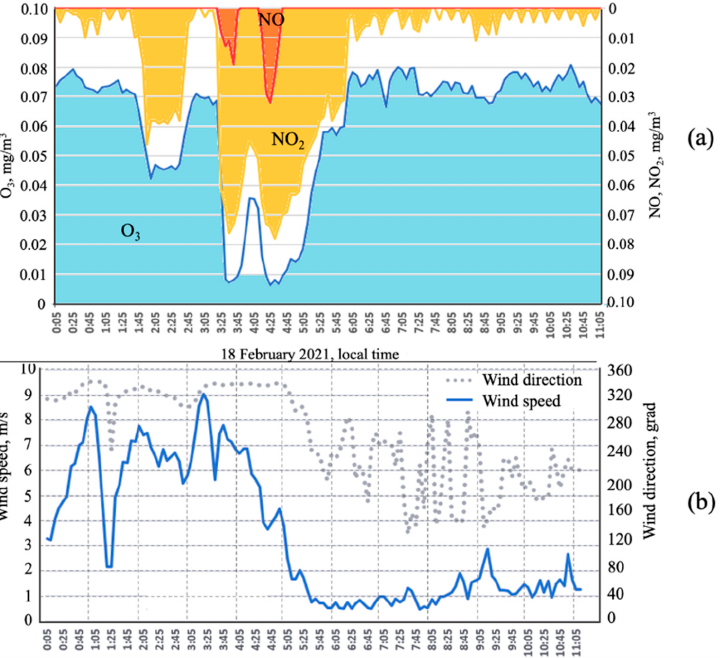
Figure 5. An example of high-altitude transport of nitrogen oxides above Listvyanka with a noctur- nal jet stream on 18 February 2021: ( a ) concentrations of O 3 , NO, and NO 2 (reverse order of values on the right scale); ( b ) wind speed and direction.